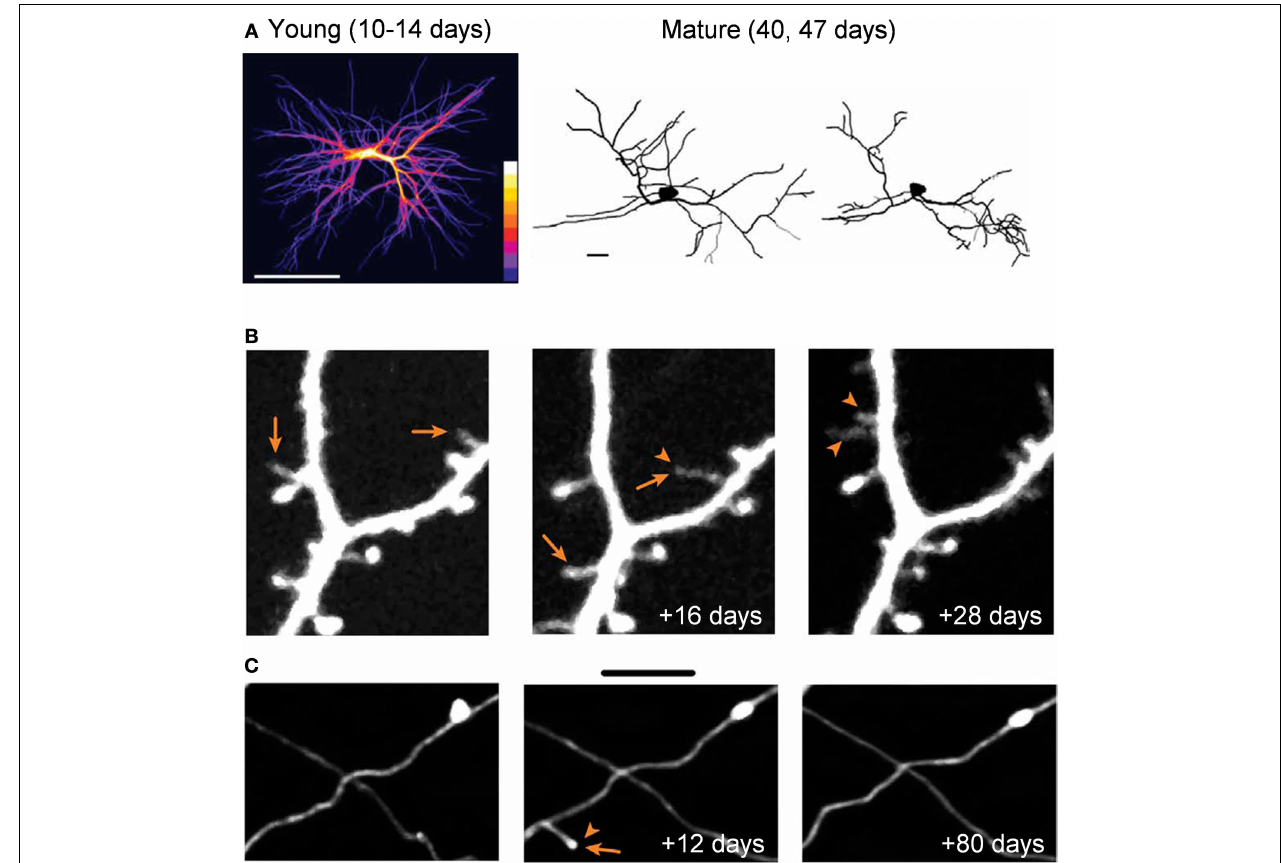
dendritic dynamics. Scale bars: 50 and 10 µm (left and right panel, respectively). (B,C) Images from in vivo time lapse imaging of dendritic spines (B) and axons (C) from the neocortex. The images are examples of the same dendritic and axonal segments that were imaged up to 28 or 80 days apart. Note both the addition (arrowhead) and loss (arrows) of dendritic spines (B) and axonal segments (C) . Scale bars: 5 µm. Panel (A) is adapted from Mizrahi (2007), with permission. Panels (B,C) are adapted from Holtmaat et al. (2009), with